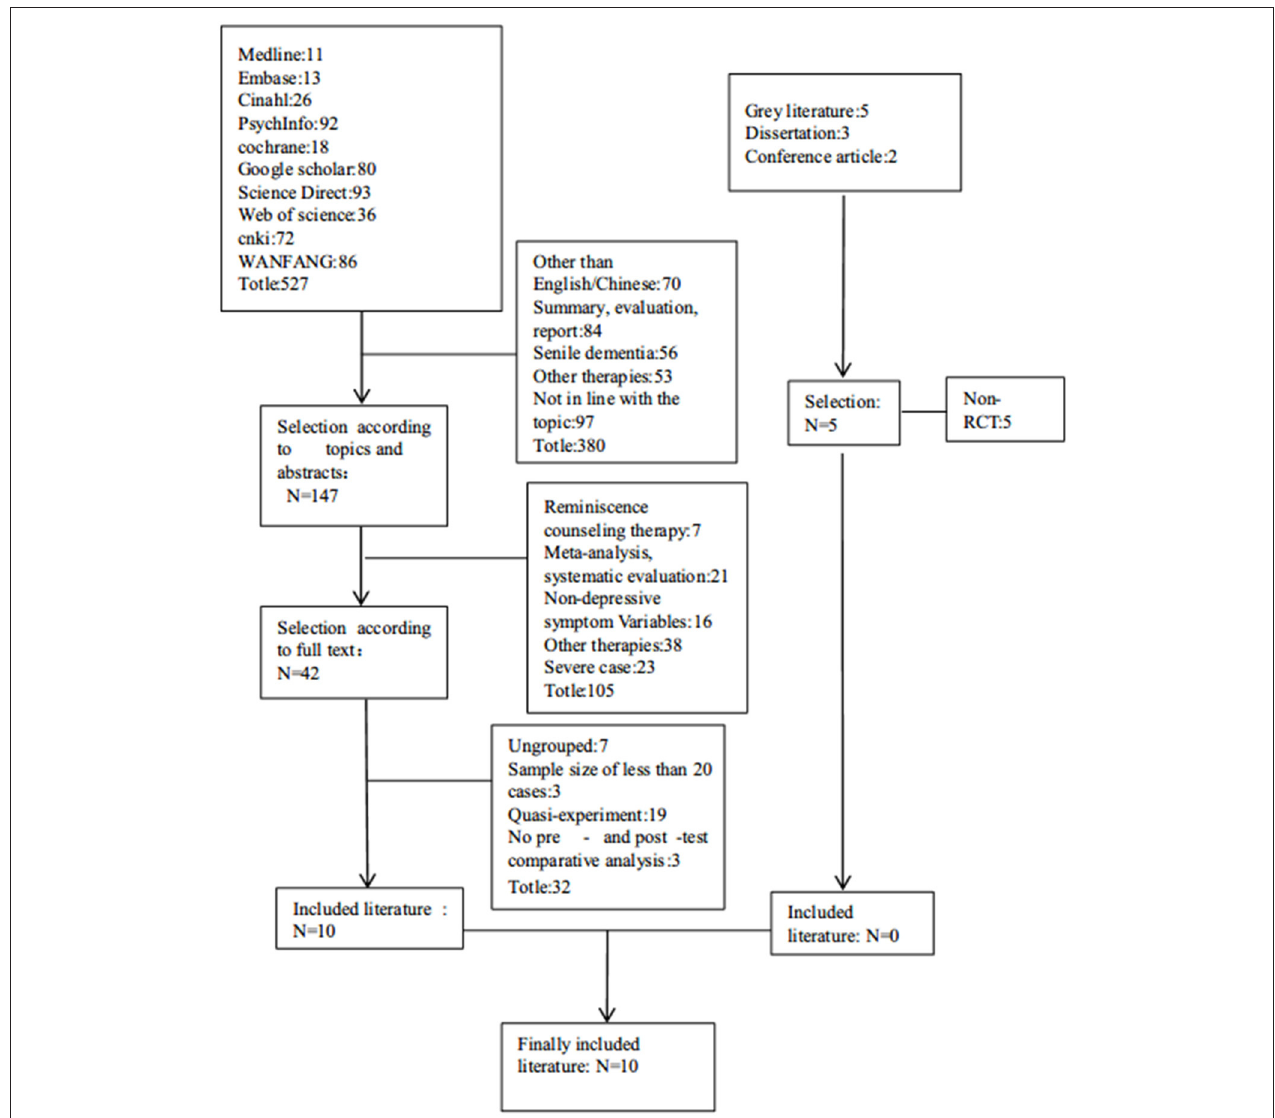
FIGURE 1 | Flow chart of the literature selection of reminiscence therapy intervention for elderly